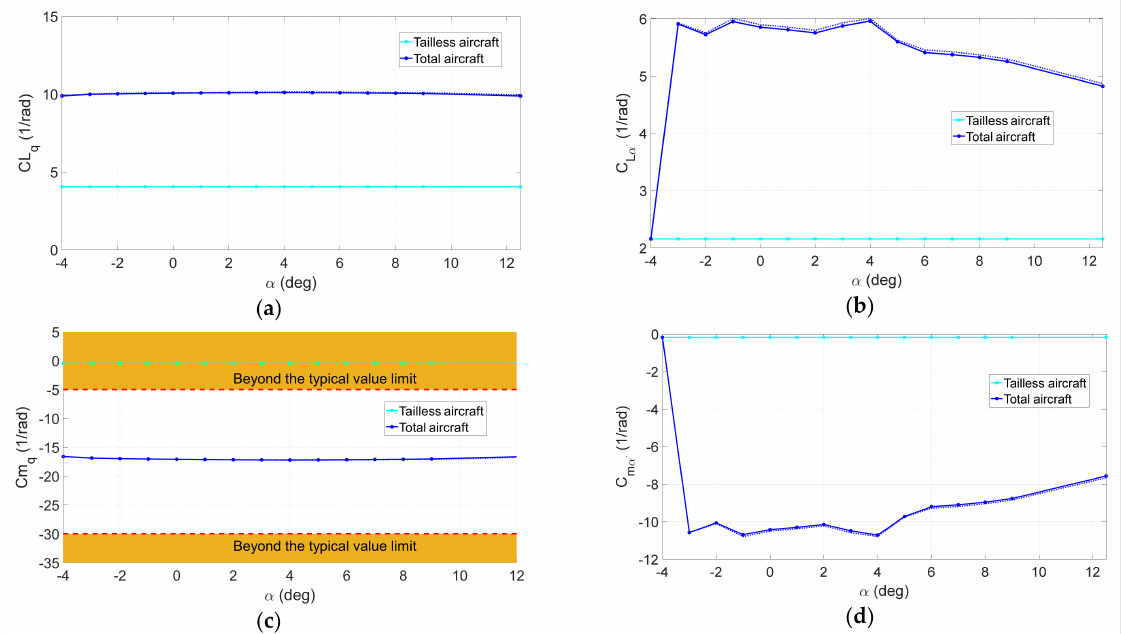
Figure 10. Longitudinal dynamic characteristics of the proposed twin-engine aircraft model: ( a ) Lift coefficient due to pitch rate results for the cruise condition; ( b ) lift coefficient due to vertical acceleration results for the cruise condition; ( c ) pitching moment coefficient due to pitch rate results for the cruise condition; ( d ) pitching moment coefficient due to vertical acceleration results for the cruise condition; (solid lines account for the optimization using mass minimization scenario and dotted-lines are for drag optimization in trim